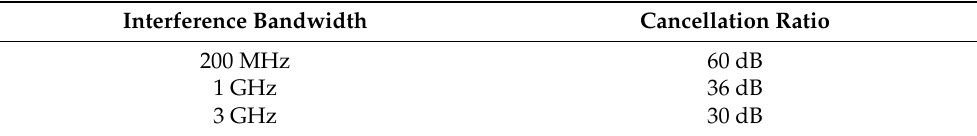
Table 1. Photonic interference cancellation ratio at different